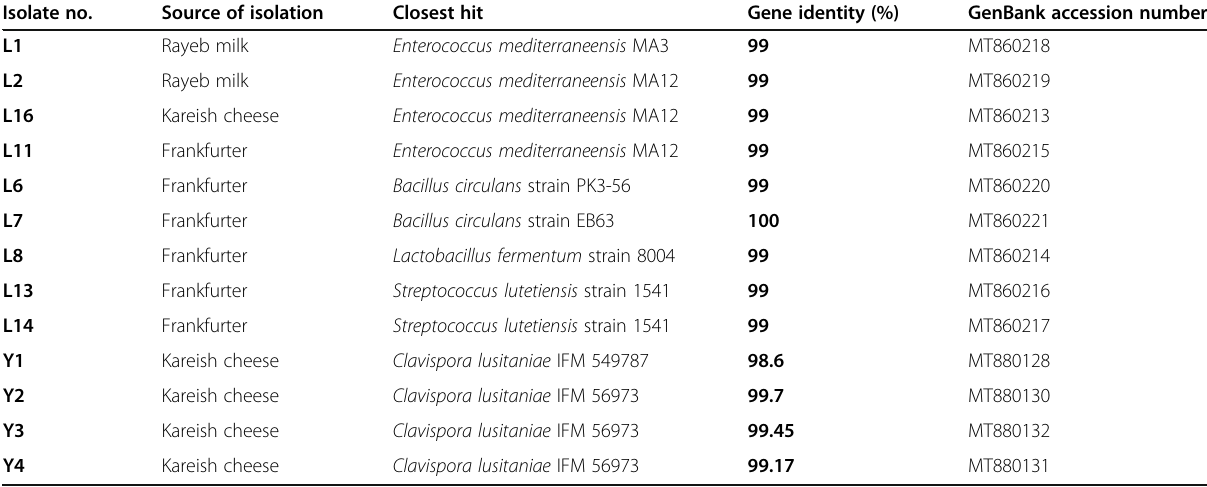
Table 2 Accession numbers and closest hits of LAB and yeast isolates Isolate